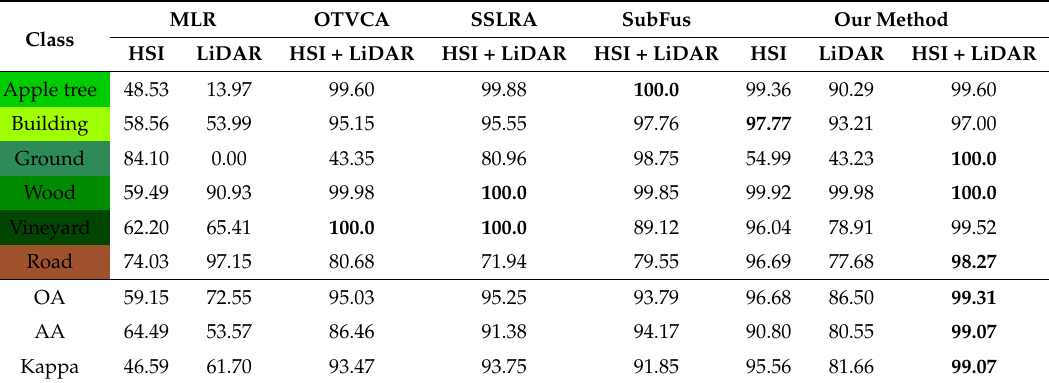
Figure 5. Classification maps obtained by different approaches on Trento dataset. ( a ) MLR on HSI. ( b ) MLR on LiDAR. ( c ) OTVCA. ( d ) SSLRA. ( e ) SubFus. ( f ) Our method on HSI. ( g ) Our method on LiDAR. ( h ) Our method. Table 2. Classification accuracies of all considered techniques on Trento